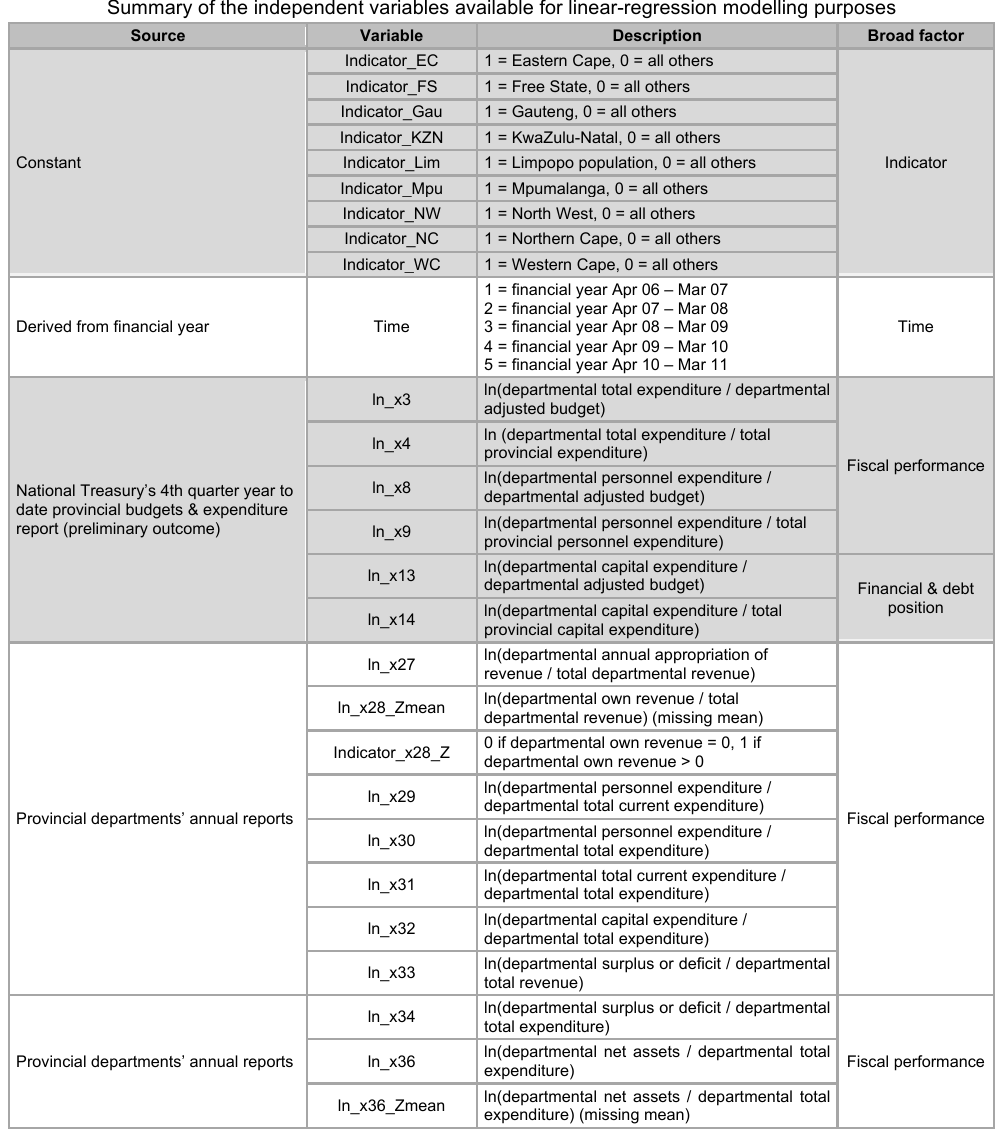
time variable was omitted from this data set. Both data sets contained 45 data points. Summary of the independent variables available for linear-regression modelling purposes Source Variable Description Broad factor Indicator_EC 1 = Eastern Cape, 0 = all